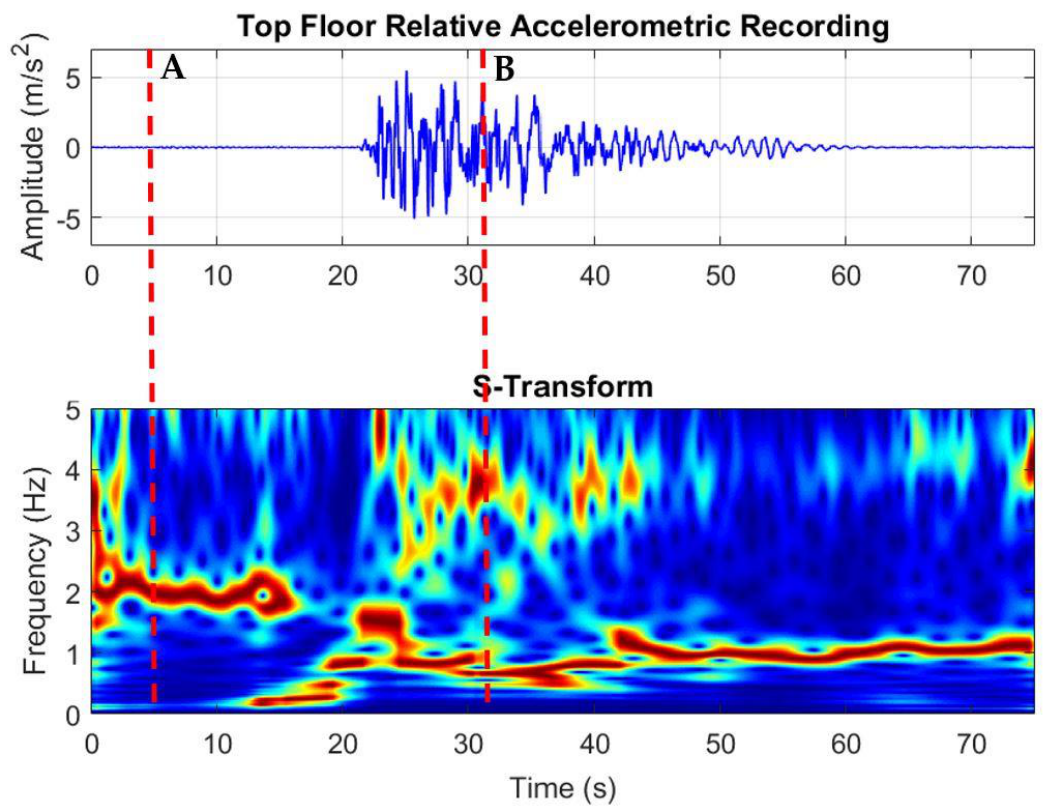
Figure 1. Top : Top floor relative accelerometric recording. Bottom : An example of the Normalized S-Transform of the signals associated with the first mode of vibration of the monitored structure and selection of the time instants ( A ) and ( B